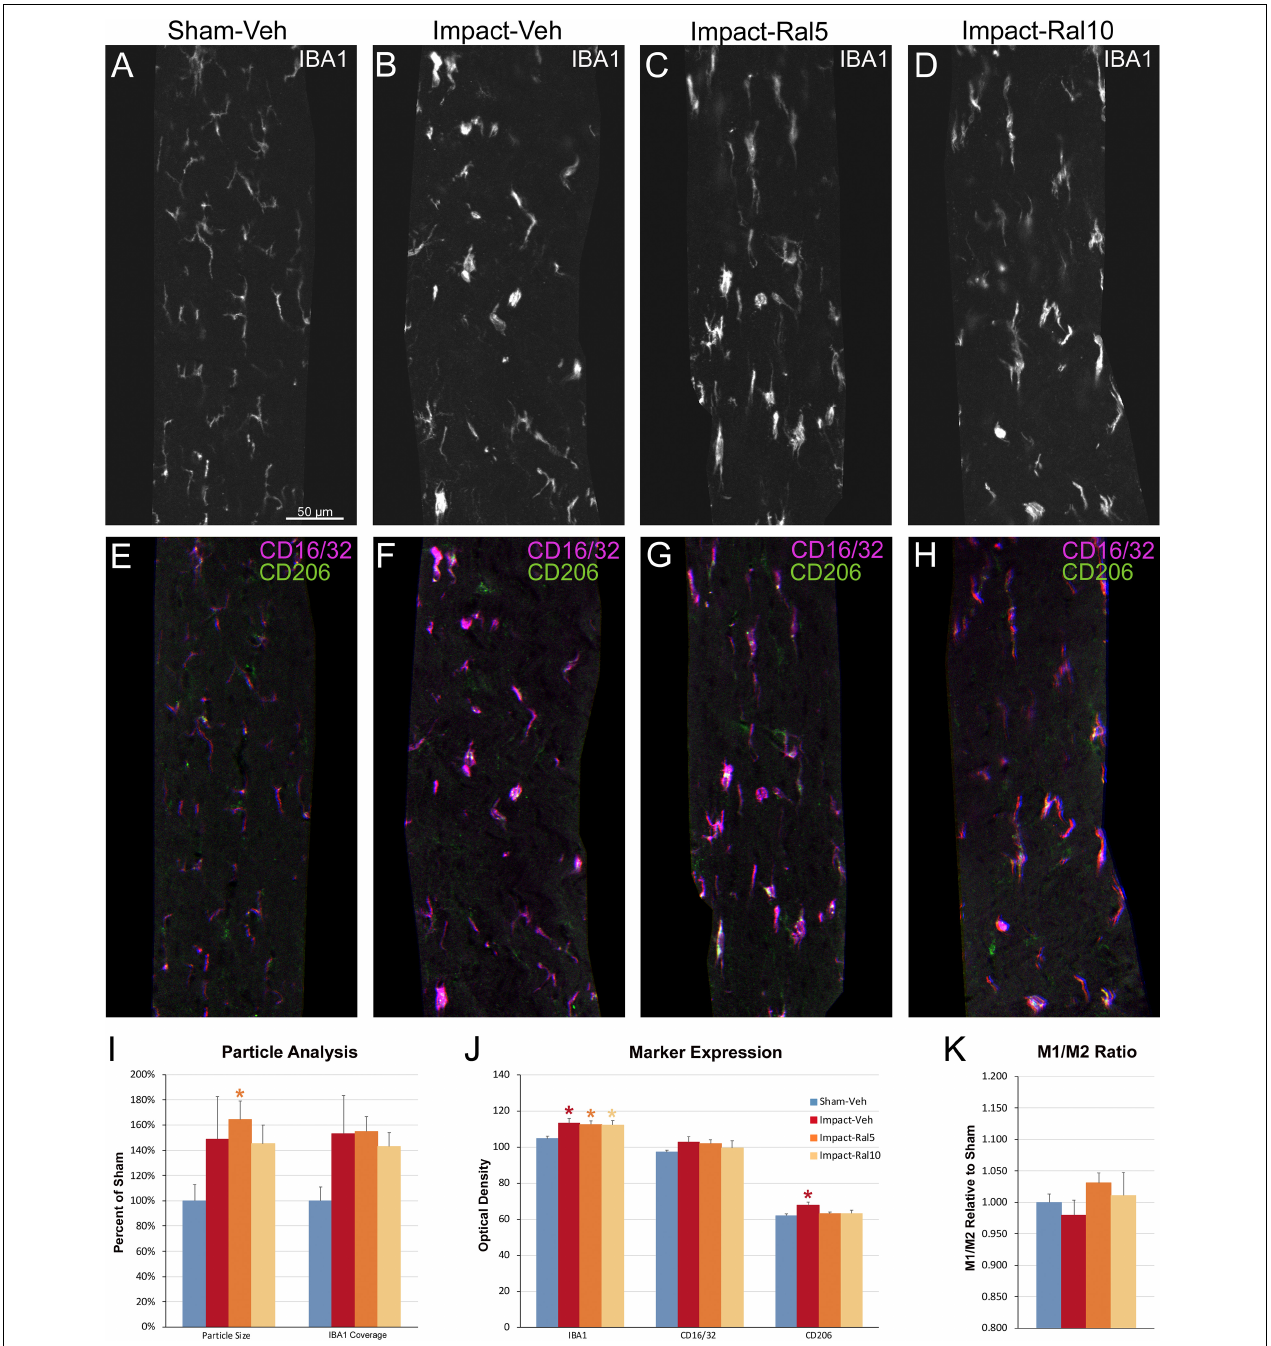
FIGURE 8 | Microglia in the optic tract 3 days after impact TBI. (A–H) Confocal images of sections immunostained for IBA1 to visualize microglia, for the M1 marker, CD16/32, and for the M2 marker, CD206. The upper panels show IBA1 immunolabeling (white), while the matching lower panels show the merge for CD16/32 (magenta) and CD206 (green). (A,E) Microglia in the sham-vehicle mouse have small cell bodies, thin processes and are lightly labeled. (B–D,F–H) Microglia are larger and more intensely labeled in the impact mice with and without raloxifene treatment. The scale bar in (A) applies to (A–H) . (I–K) Quantification of IBA1, CD16/32, and CD206 immunolabeling. For impact-vehicle mice, optic tract area occupied by microglia and size of IBA1+ particles were increased, IBA1, CD16/32, and CD206 expression were all slightly increased, but CD206 expression showed a slightly larger increase than CD16/32, resulting in a slightly lower M1/M2 ratio than in sham mice. The two doses of raloxifene after impact TBI similarly were associated with an increased microglial area, size of IBA1+ particles, and IBA1 and CD16/32 expression. However, as CD206 expression in raloxifene-treated mice was slightly higher than in sham mice and less than in impact-vehicle mice, their M1/M2 ratios were higher. Numbers of optic tracts analyzed: 11 sham-vehicle mice, 15 impact-vehicle mice, 16 impact-ral5 mice, and 16 impact-ral10 mice. Red, orange, and yellow asterisks indicate significant differences between the impact-vehicle mice, impact-ral5 mice, and impact-ral10 mice, respectively, compared to the sham-vehicle mice; * p <